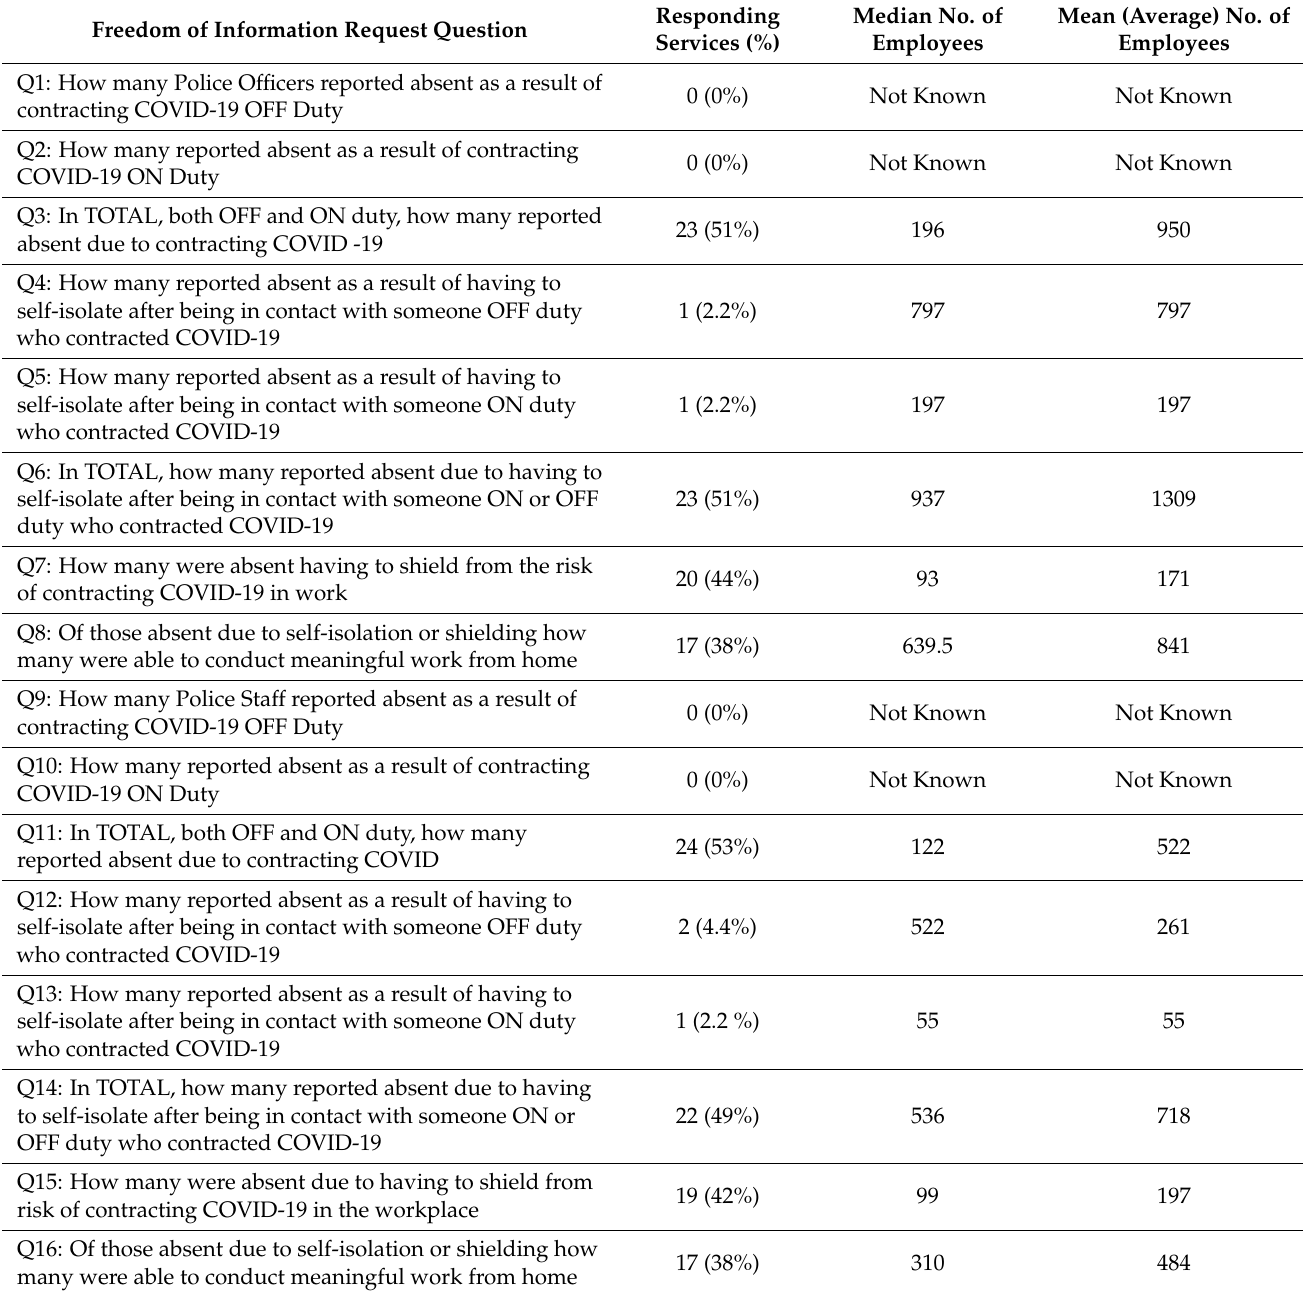
Table 1. List of Freedom of Information Request Questions and Response